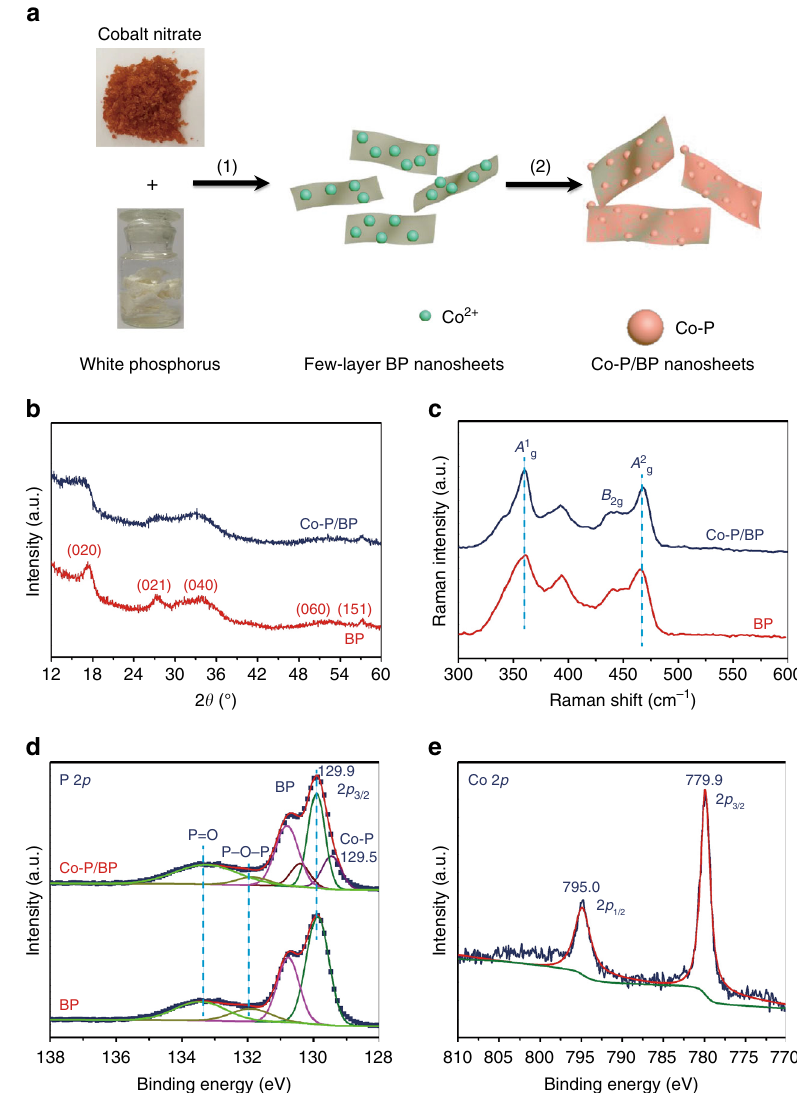
Fig. 1 Spectroscopic characterizations of the as-prepared BP-based samples. a The formation process of the Co-P/BP nanosheets: (1) phase transition processes, (2) supporting process via the reaction between the formed BP nanosheets and Co(NO 3 ) 2 . The reaction was run in ethylenediamine, followed by heating at 140 °C for 12 h, respectively. b XRD patterns of the BP (red line) and Co-P/BP (navy line) samples. c Raman spectra of the pristine BP and Co- P/BP samples. The excitation wavelength is 633 nm. d , e XPS fi ne spectra of P 2 p and Co 2 p states in the samples. The C 1 s (284.8 eV) is the charged correction